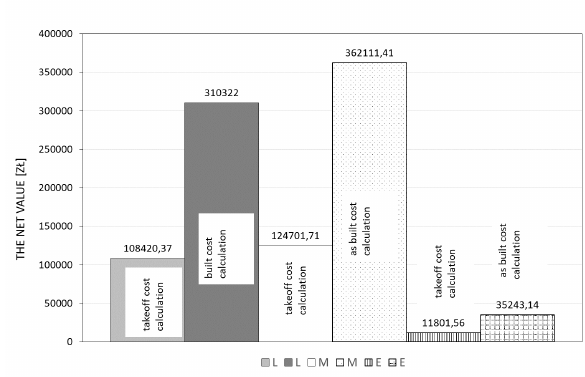
Figure 3: Comparison of definitive cost and as-built cost estimated of selected renovation works with the division into labor, materials and